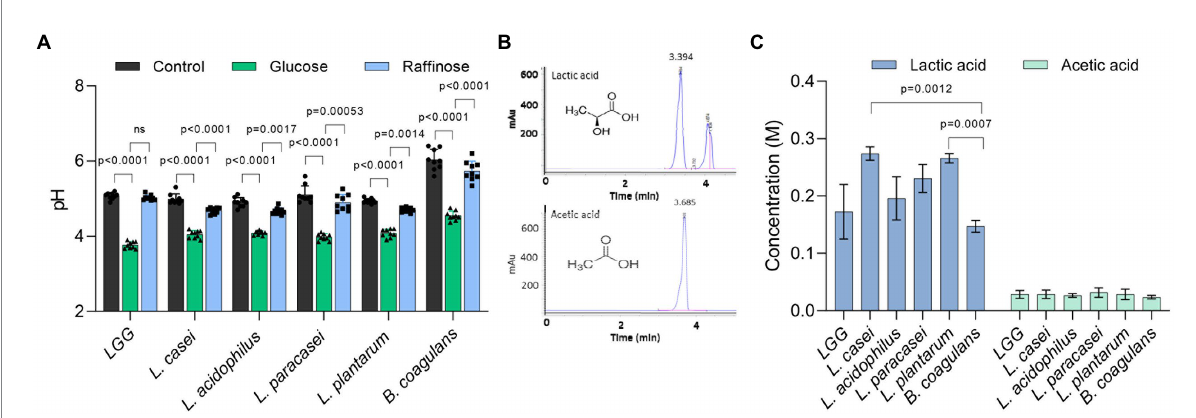
FIGURE 3 The variation at the species level in growth enhancement is not due to glucose catabolism. (A) The pH of the conditioned media of indicated species in TSB medium (control) and TSB medium supplemented with glucose (1% W/V) and raffinose (1% W/V). Statistical analysis was performed using two-way ANOVA followed by Dunnett’s multiple comparison test. p < 0.05 was considered statistically significant. (B) HPLC chromatograms indicate an exclusive peak and stable retention time for the pure standards of lactic acid and acetic acid. (C) The concertation of lactic acid and acetic acid produced by the indicated species. Bacteria were grown on an MSgg medium supplemented with glucose (1% W/V) for 24 h. The conditioned medium from the cultures was collected and analyzed using the C-18 column. Statistical analysis was performed using Brown- Forsythe and Welch’s ANOVA with Dunnett’s T3 multiple comparisons test. p < 0.05 was considered statistically